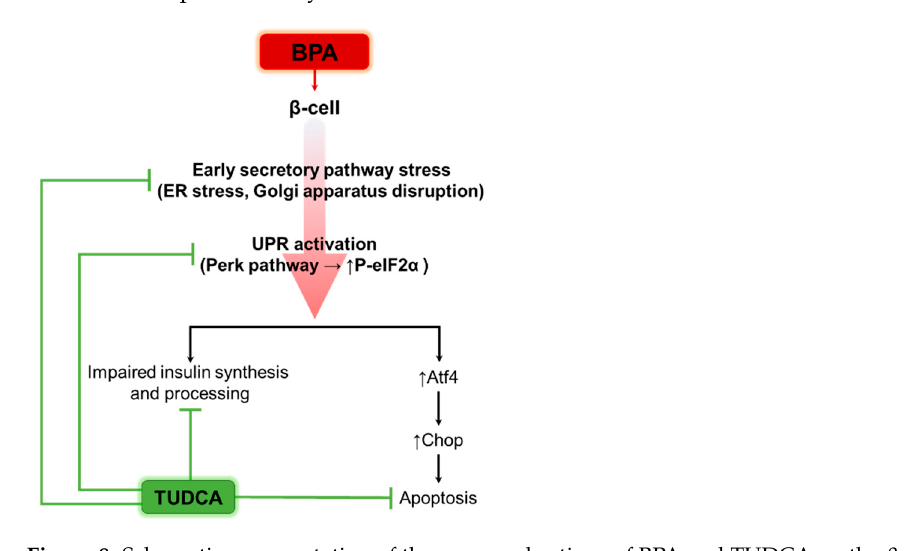
Figure 8. Schematic representation of the proposed actions of BPA and TUDCA on the β